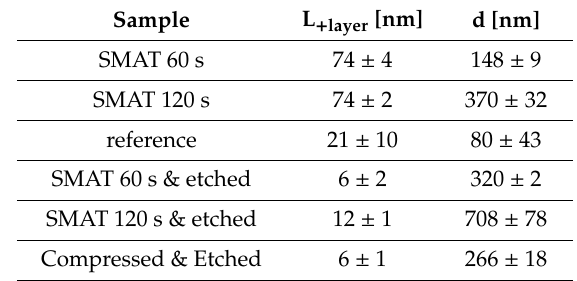
Table 2. Results of fitting of the S(E) curves. L + layer is the positron di ff usion length in the surface layer of the samples, which is di ff erent from the magnesium matrix, and d is the thickness of this surface.